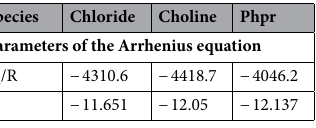
Table 7. The Arrhenius equation parameters of species of studied DES.